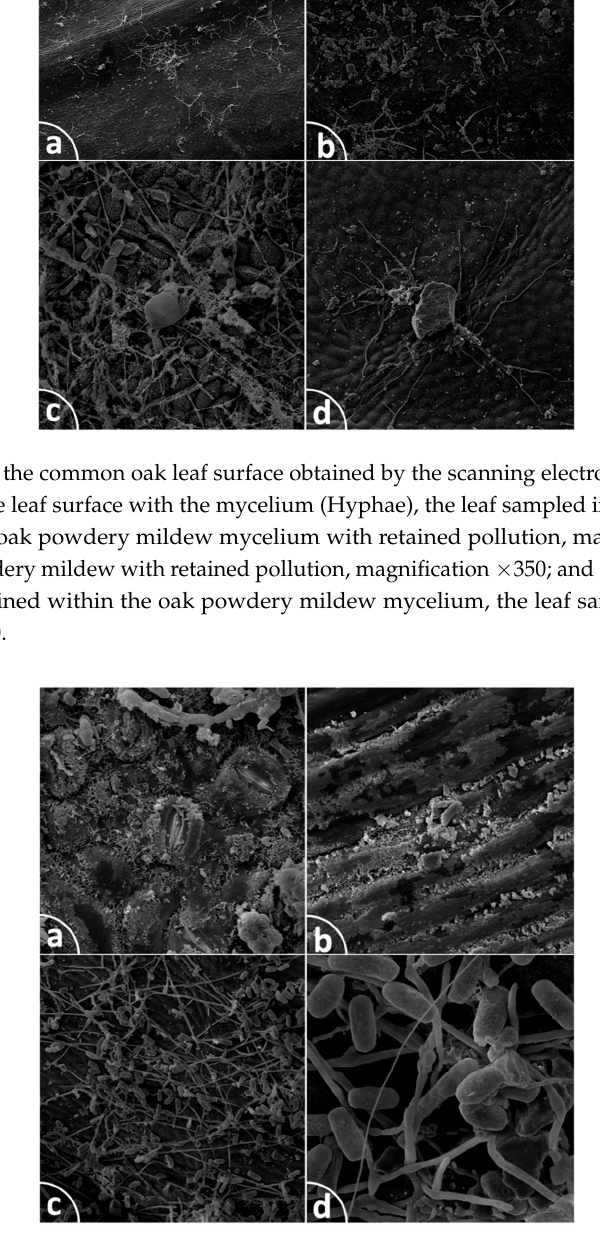
Figure 4. Dependence of canopy water storage capacity from the month of sampling; V, samples taken in May; IX, samples taken in September. Table 3. Analysis of the influence of the leaf sampling time on S (g/g). Month